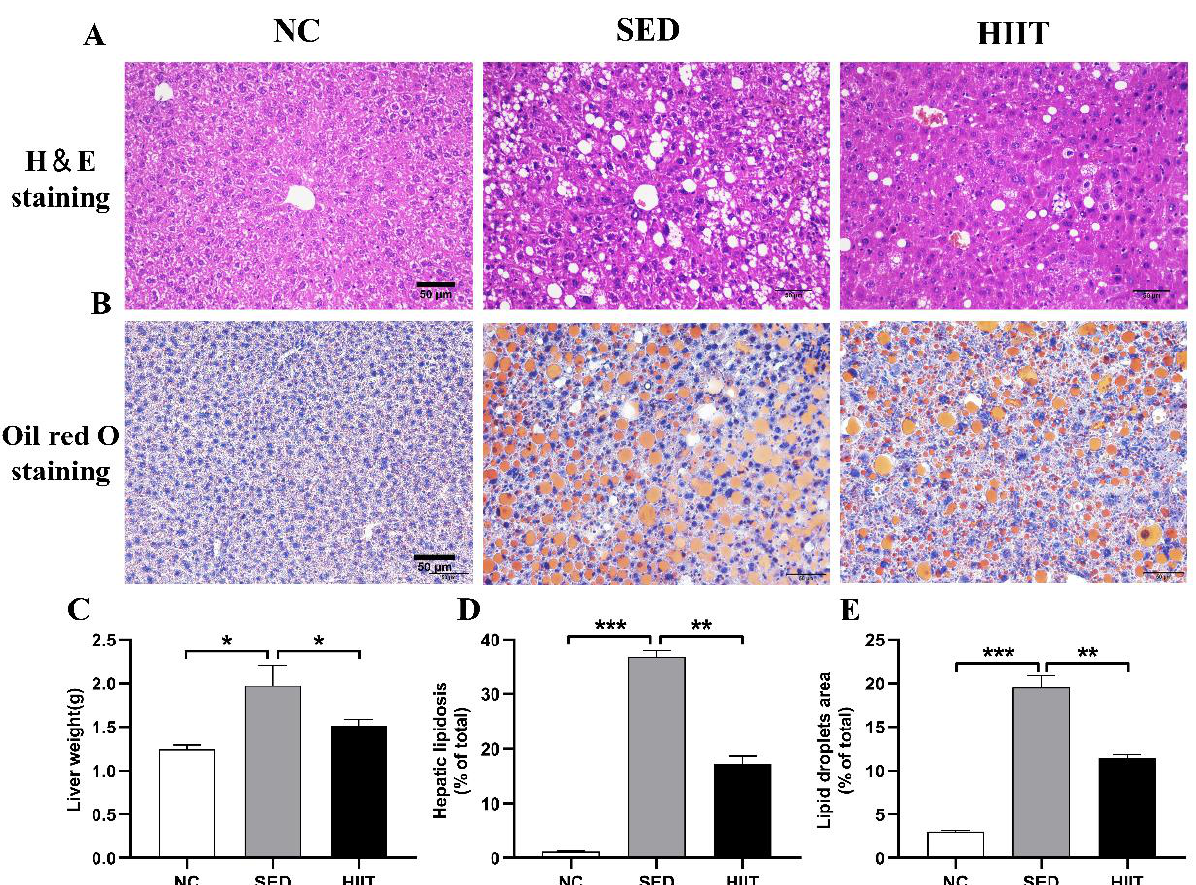
Figure 2. HIIT reduces hepatic fat content in T2DM mice. ( A ) Hematoxylin and eosin (H&E) staining of the liver. ( B ) Oil Red O staining of the liver. ( C ) Liver weight (n = 4 per group). ( D ) Hepatic lipid deposition (n = 4 per group). ( E ) Liver lipid droplet area (n = 4 per group). The black scale is 50 µ m. Values are mean ± SEM. * p < 0.05, ** p < 0.01, *** p < 0.001.